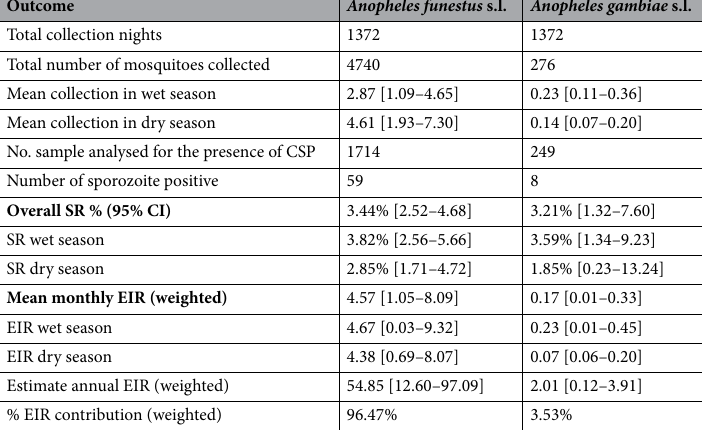
northern zone = 0.93, southern zone = 8.04; Density Ratio (DR) = 6.09 [95% CI 3.00–12.38]; p < 0.001) (Table 2). There were significantly more An. funestus s.l. sampled from households in the southern part of the study area (average/house/night = 7.85), compared to the North (0.72; DR = 7.92 [95% CI 3.76–16.67]; p < 0.001). However, there was no statistical difference in An. gambiae s.l. collected between the two locations with an average of 0.21 per night in the northern zone and 0.19 in the southern zone (DR = 1.28 [95% CI 0.69–2.38]; p = 0.431) (Table 2). Amongst sibling species of the An. gambiae complex, there were marked spatial and seasonal fluctuations. Most An. gambiae s.s. (94.3%) were collected from the northern zone and more than 71.5% of An. funestus s.s. from the southern part. An. arabiensis was distributed throughout both study zones, but its abundance was slightly higher in the South (Table 2). Both An. funestus s.s. and An. arabiensis predominated throughout the study period, but An. gambiae s.s. abundance peaked in December in the middle of the rainy season. An analysis of bioclimatic and landcover characteristics across the study area demonstrated several ecological differences between the northern and southern zones, with the former composed mostly of grassland and cropland (91%), with smaller proportions of shrubland and forest (7%) and areas prone to regularly flooding (1%); and the latter with less grassland and cropland (80%) and greater proportions of shrubland and forest (14%) and areas prone to regular flooding (3%) (Supplementary table S1). Furthermore, differences in rainfall were also observed between the northern and southern zones, with villages in the North receiving slightly higher average annual precipitation (959.5 mm) than in the South (911.5 mm). While overall An. gambiae s.l. density was low, it was closely correlated with seasonal rainfall patterns. Mean An. gambiae s.l. caught per house during the dry season (August and September; average precipitation of 5–7 mm) was 0.14 but rose significantly by two-fold (DR = 1.73 [95% CI 1.08–2.78]; p = 0.02) in the wet season (October, November and December; average precipitation of 147.3–158.5 mm). By comparison, signifi- cantly higher An. funestus s.l. densities were observed during the dry months [mean = 4.61; Incidence Rate Ratio (IRR) = 1.58, p = 0.004] (Table 3). The majority of sleeping spaces/beds where the CDC-LTs were installed had either Olyset (60.5%; 830/1372) or PermaNet 2.0 LLINs (36.0%; 494/1372); 0.5% (7) had both Olyset and PermaNet LLINs, previously distributed through mass universal replacement campaigns (URCs) that was conducted between 2014 and 2017 to achieve universal coverage 33 . The remaining 2.6% (35) of nets had no labels and 0.4% (6) were missing data on net type. There was no significant difference in malaria vector densities between rooms with the two main types of LLIN (average number of malaria vectors per house per night with Olyset LLINs = 3.59 [95% CI 1.64–.54], versus PermaNet 2.0 LLINs = 3.89 [95% CI 1.78–6.00]; p = 0.111). Plasmodium falciparum infection and entomological inoculation rate. A total of 1963 Anopheles mosquitoes (603 and 1360 from the northern and southern clusters, respectively) were tested for the presence of Plasmodium falciparum circumsporozoite protein (CSP), with 67 found infected, giving an overall sporozoite rate of 3.4% [95% CI 2.5–4.6] (Table 2). Of the An. gambiae s.l. and An. funestus s.l. individuals which tested CSP positive, 6.1% (4/66) were An. gambiae s.s., 1.5% (1/66) An. arabiensis , and 77.3% (51/66) An. funestus s.s., respectively; the remaining samples could not be amplified by PCR. Sporozoite rates were similar in An. funestus s.l. (3.44%) compared to An. gambiae s.l. (3.21%) (Table 3). Overall sporozoite rate varied across the study area with the highest rates observed in the southern zone (Table 2; odds ratio (OR) = 1.88, [95% CI 1.02–3.46]; p = 0.044). In southern clusters, sporozoite rates for An. funestus s.l. was significantly higher than in northern clusters (OR = 2.33, [95% CI 1.11–4.95]; p = 0.028). The monthly sporozoite rate for An. funestus s.l. and An. gambiae s.l. fluctuated across the dry and wet seasons with slightly higher, but not significant, rates in the wet season (Table 3). An. funestus s.s. maintained malaria transmis- sion across both seasons (sporozoite rates of 2.85% [95% CI 1.71–4.72] and 3.82% [95% CI 2.56–5.66], during the dry and wet seasons, respectively) while An. gambiae s.s. appeared to contribute to transmission mainly in